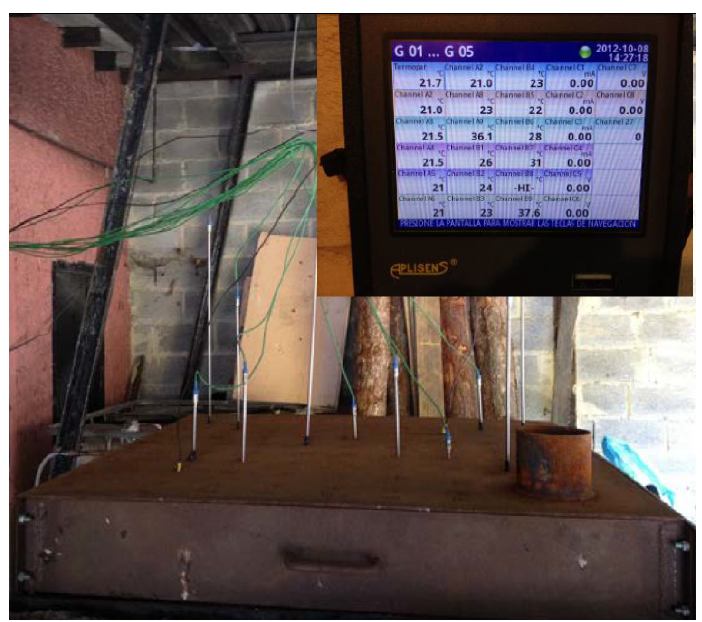
Figure 1. Installation for the tests.